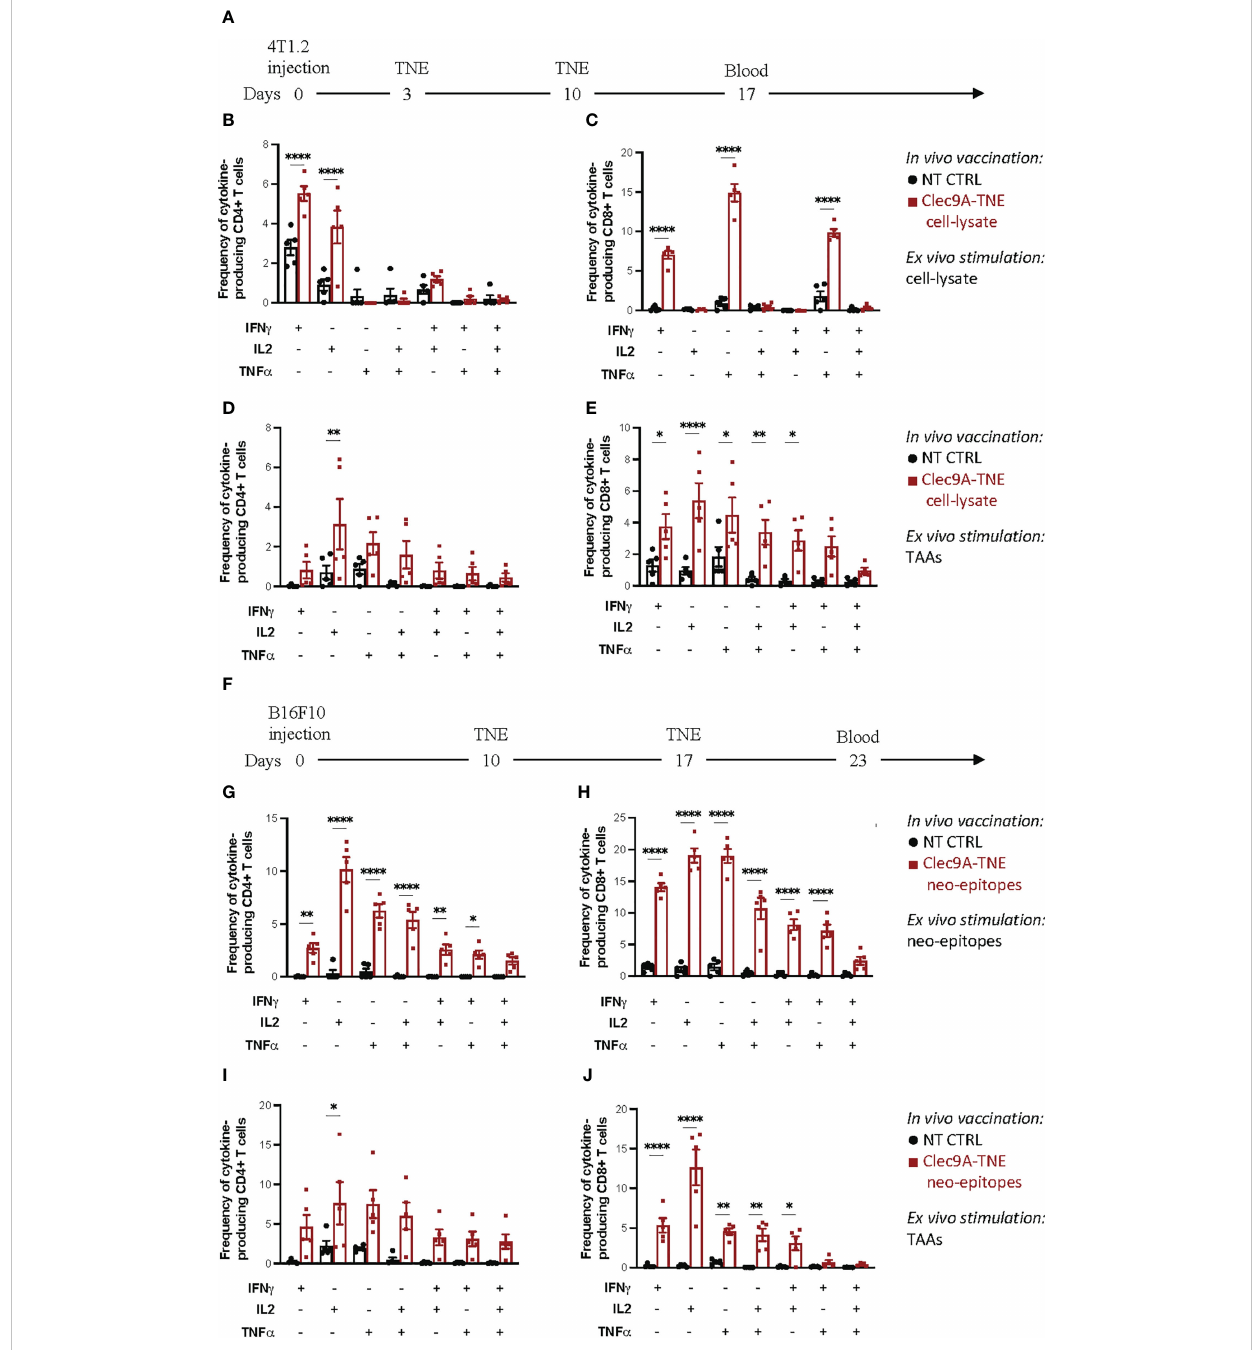
FIGURE 1 Polyfunctional assay on blood T cells. (A) Experimental scheme: Balb/c mice were orthotopically injected with 0.5×10 6 4T1.2 cells. Three and 10 days after tumor injection, mice were injected i.v. with Clec9a-TNE loaded with the 4T1.2 cell-lysate. On day 17 blood was collected and process as described in Methods. Cytokine production in CD4 + and CD8 + T cells was measured by fl ow cytometry and intracellular cytokine staining after ex vivo stimulation of blood samples with tumor lysate (B, C) or a pool of tumor associated antigen (TAA) for 6 h (D, E). (F) Experimental scheme: C57BL/6 mice were subcutaneously injected with 0.25×10 6 B16F10 cells. Ten and 17 days after tumor injection, mice were injected i.v. with Clec9a- TNE loaded with a pool of functionally validated, immunogenic B16F10 neo-epitopes. On day 23 blood was collected and process as described in Methods. Cytokine production in CD4 + and CD8 + T cells was measured by fl ow cytometry and intracellular cytokine staining after ex vivo stimulation of blood samples with B16F10 neo-epitopes (G, H) or a pool of tumor associated antigen (TAA) for 6 h (I, J) . Data are presented as mean values ± SEM. 0.1234 (ns), 0.0332 (*), (**) 0.0021, <0.0001 (****) (Two-Way